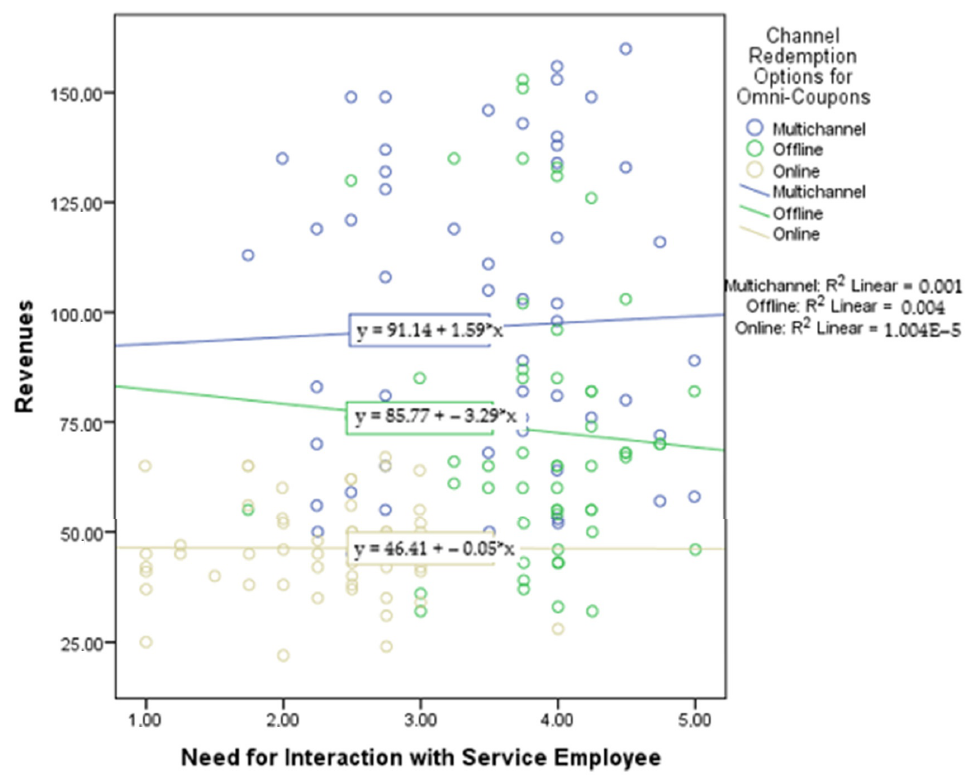
Figure 4. Revenues in relation to the need for interaction with service employees across channel redemption options for